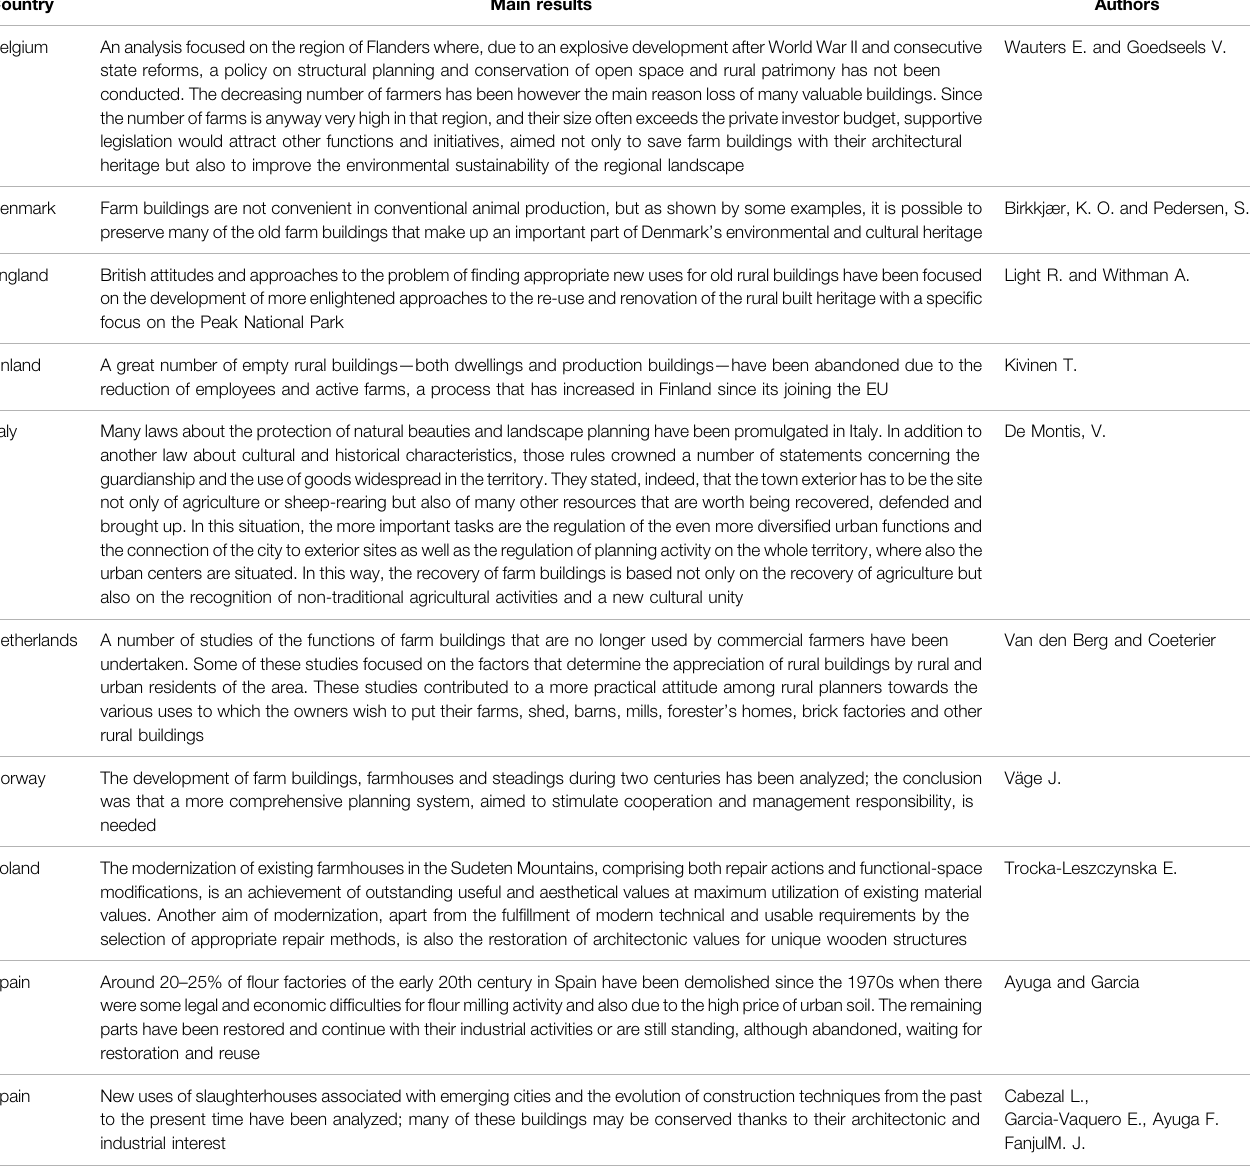
TABLE 2 | Main results of the typological analysis of old farm buildings in Europe.